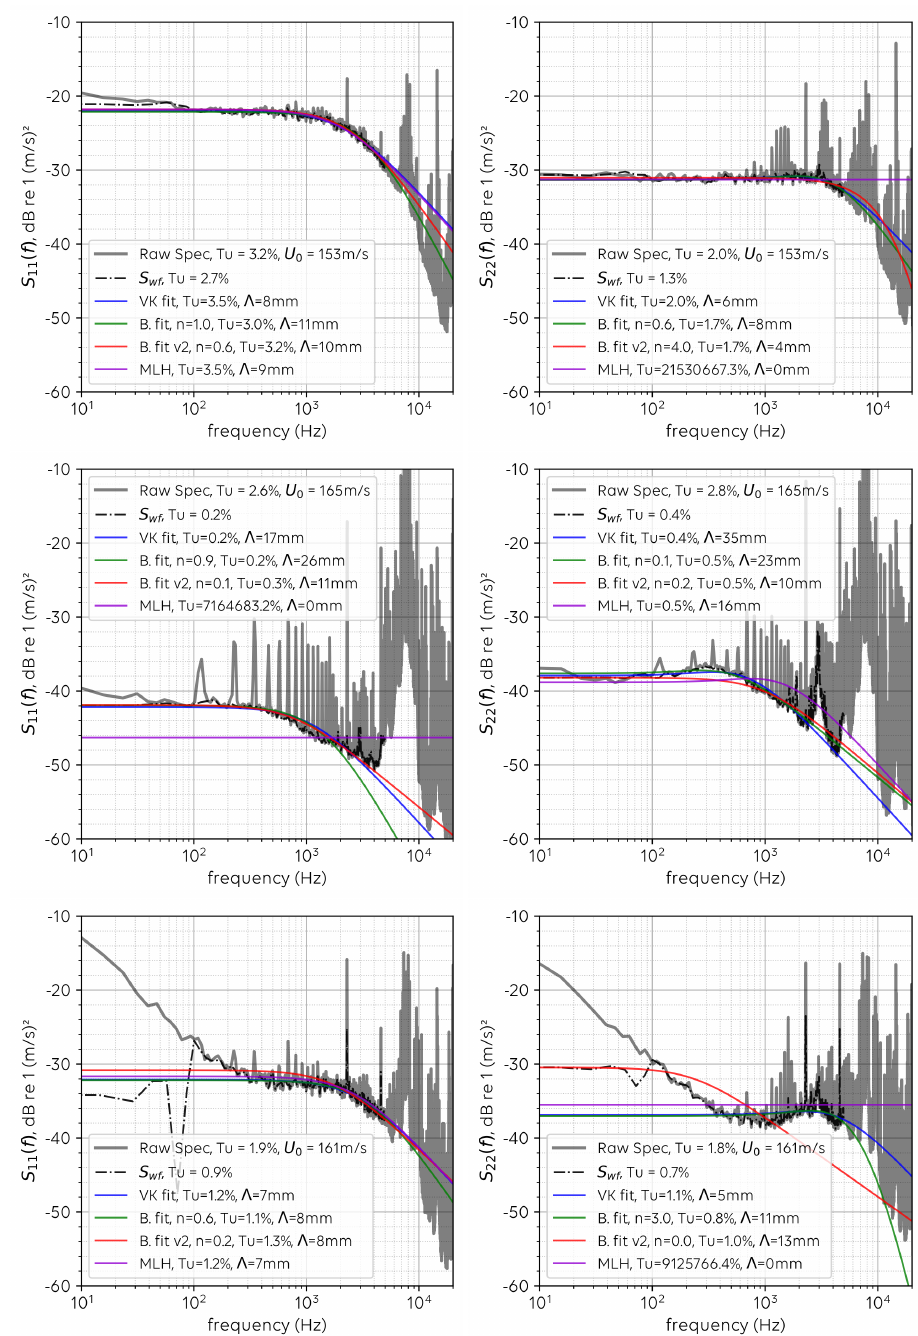
Figure 11. Results for the turbulence parameter estimation techniques at selected radial positions. Left plots refer to the longitudinal velocity component, whereas right plots to the transverse. Top plots are measurements performed inside the boundary layer, whereas the mid and bottom plots outside of it. In mid plots, strong tones are present in the spectra obtained from raw data. The fan operating point is the same for all plots and η 2 ≈ 6840 RPM. Bottom plots refer to the same test point as analyzed in Section